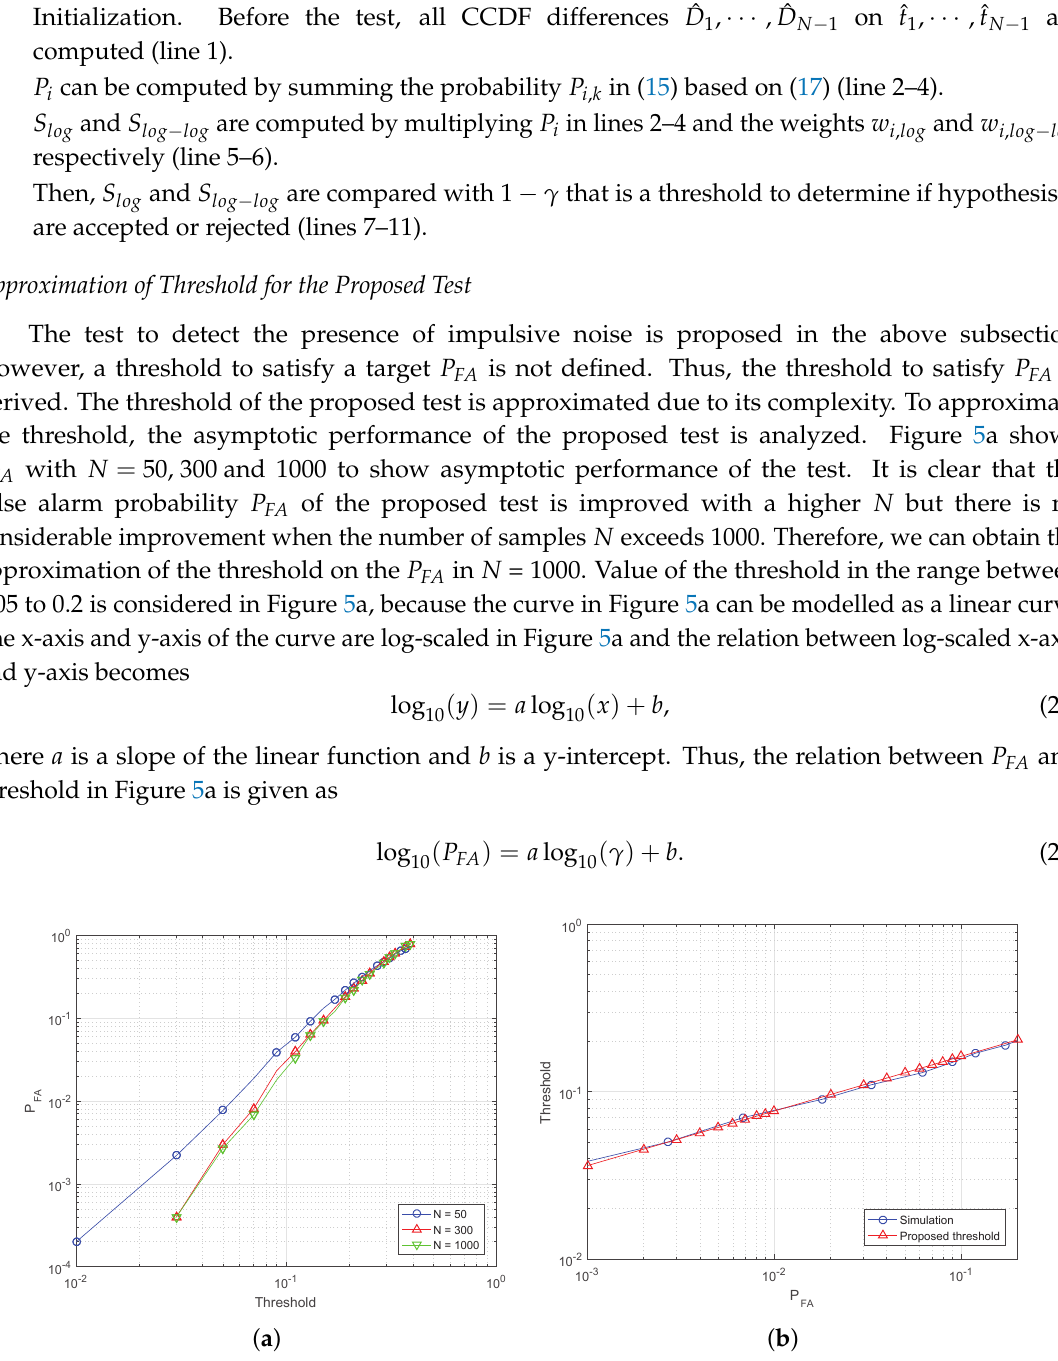
Figure 5. Illustration of theoretical CCDF of AWGN and empirical CCDFs of impulsive noise models. ( a ) Plotting threshold versus P FA in N = 50, 300 and 1000. ( b ) Plotting P FA versus simulation results of threshold in N = 1000 and derived threshold in